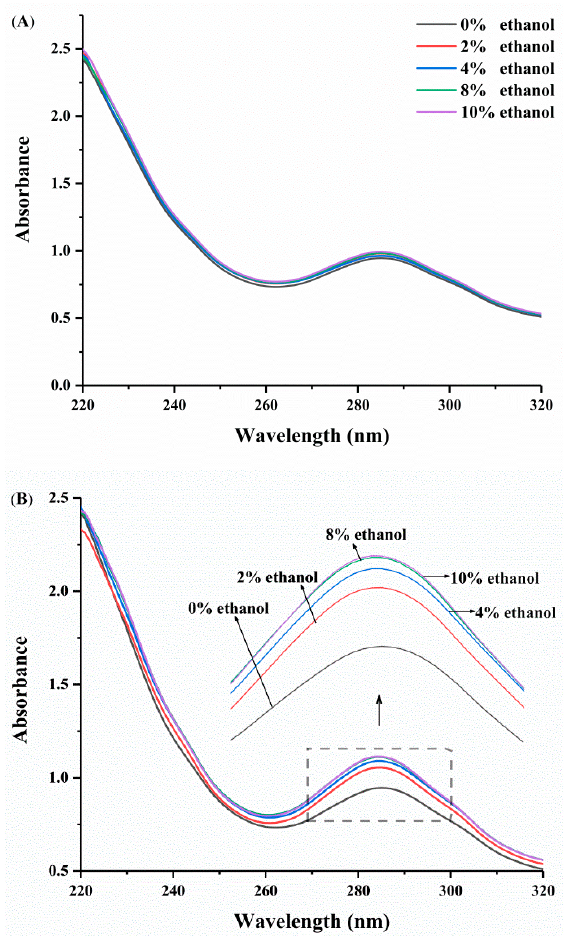
Figure 5. The UV spectra of pectin treated with ( B ) or without ( A ) DHPM under different ethanol concentrations.